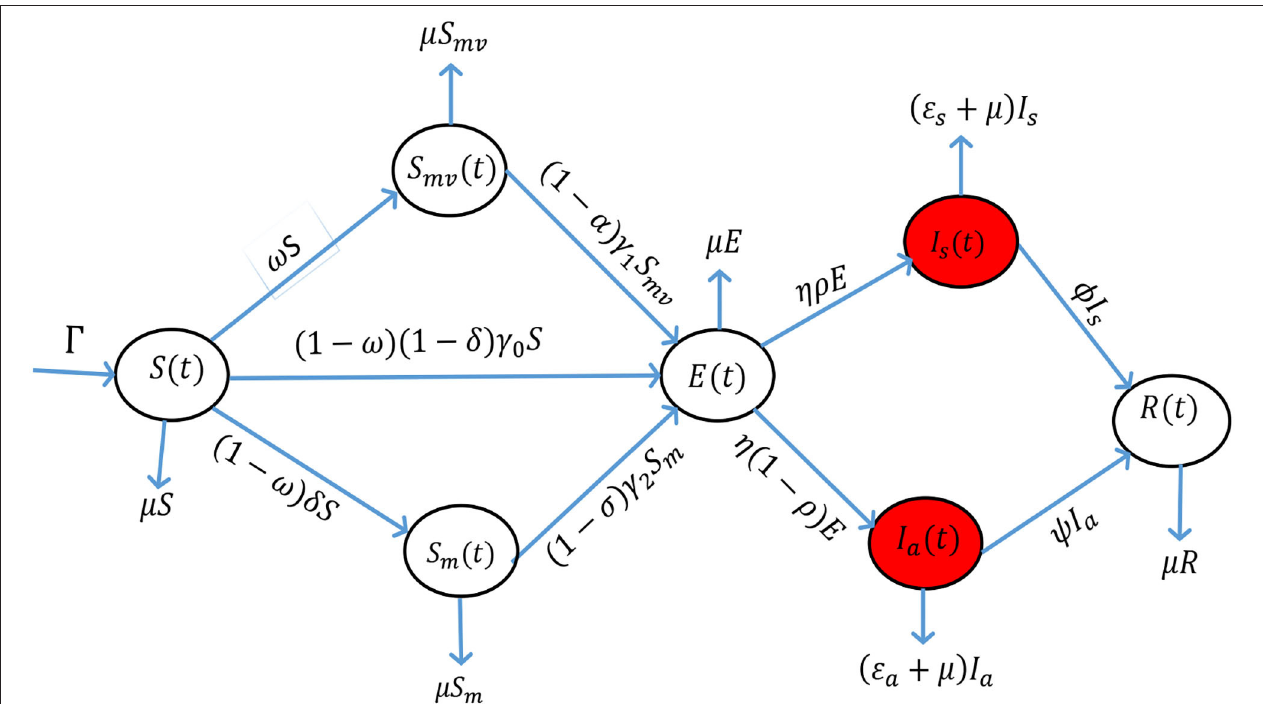
FIGURE 1 | The proposed model incorporating a combination of vaccination against COVID-19 and wearing of face masks.